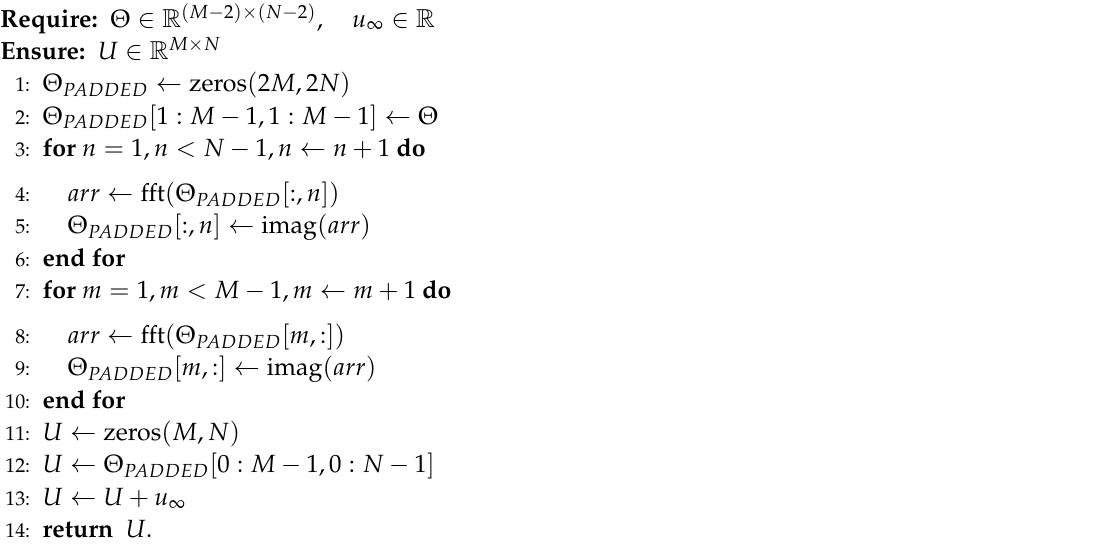
Algorithm 2 Retrieve temperature using a Fast Fourier Transform (FFT) with zero